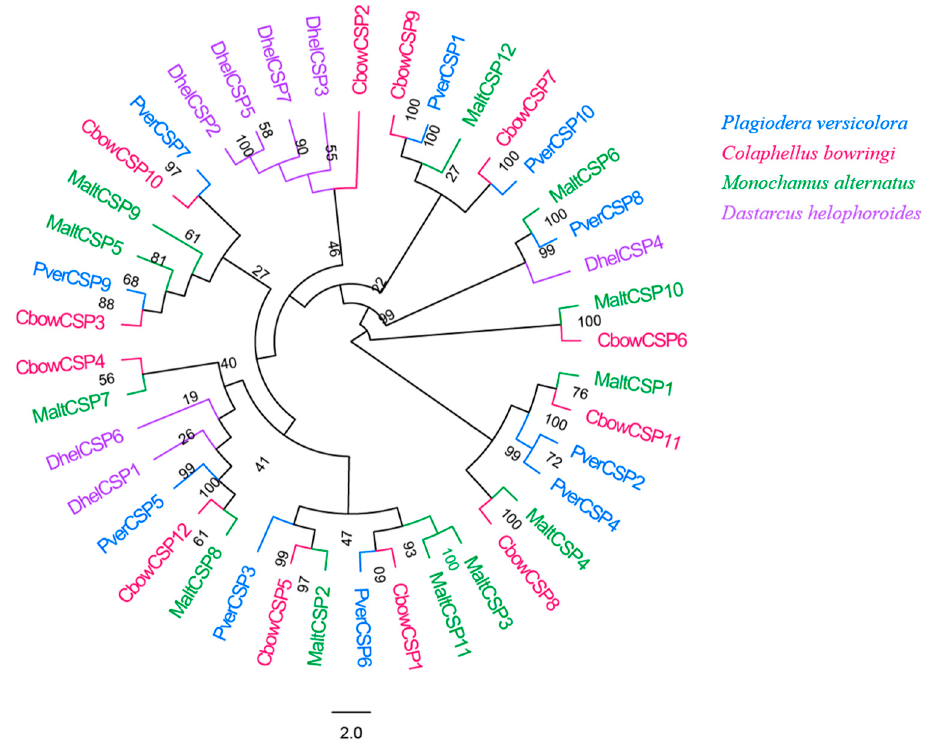
Figure 5. Phylogenetic tree of insect CSP. The P. versicolora genes are shown in blue. The tree was constructed using MEGA6 with the Neighbor-joining